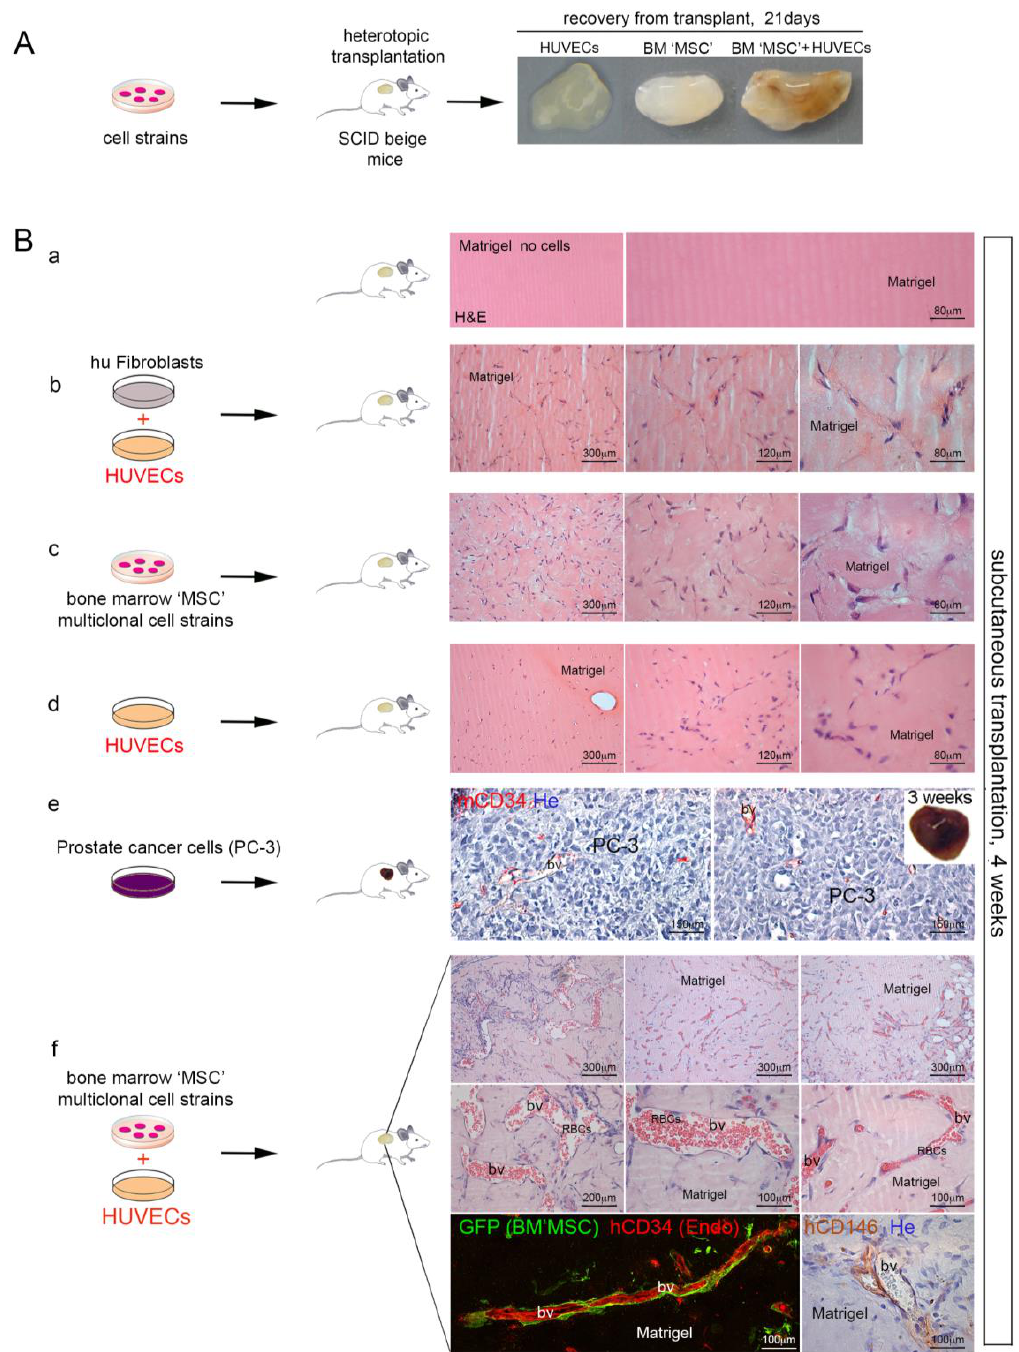
Figure 7. ( A ) formation of vascular networks by BM mesenchymal stem cells (MSCs) in vivo . Human foreskin fibroblasts and human BMSCs with or without HUVECs were resuspended in Matrigel TM and implanted on the backs of SCID / beige mice by subcutaneous injection. Gross appearance of ectopic transplants harvested at three weeks. ( B ) H&E staining of implants harvested after four weeks revealed the presence of lumenal structures (bv) containing erythrocytes (RBCs) in implants where both cells HUVECs and hBMSCs cells were used (f) but not in implants where human foreskin fibroblasts were co-transplanted with HUVECs (b), or when human fibroblasts, or hBMSCs (c) were used alone. Images are representative of implants harvested at four weeks. Human PC-3 cells growth e ffi ciently up to form tumors vascularized by murine vessels, when locally grafted in this matrix (e). H&E, Hematoxylin / Eosin; bv, blood vessels; RBCs, red blood cells. He, Hematoxylin counterstaining. Scale bar = 80 µ m, 120 µ m, 150 µ m, 200 µ m, 300 µ